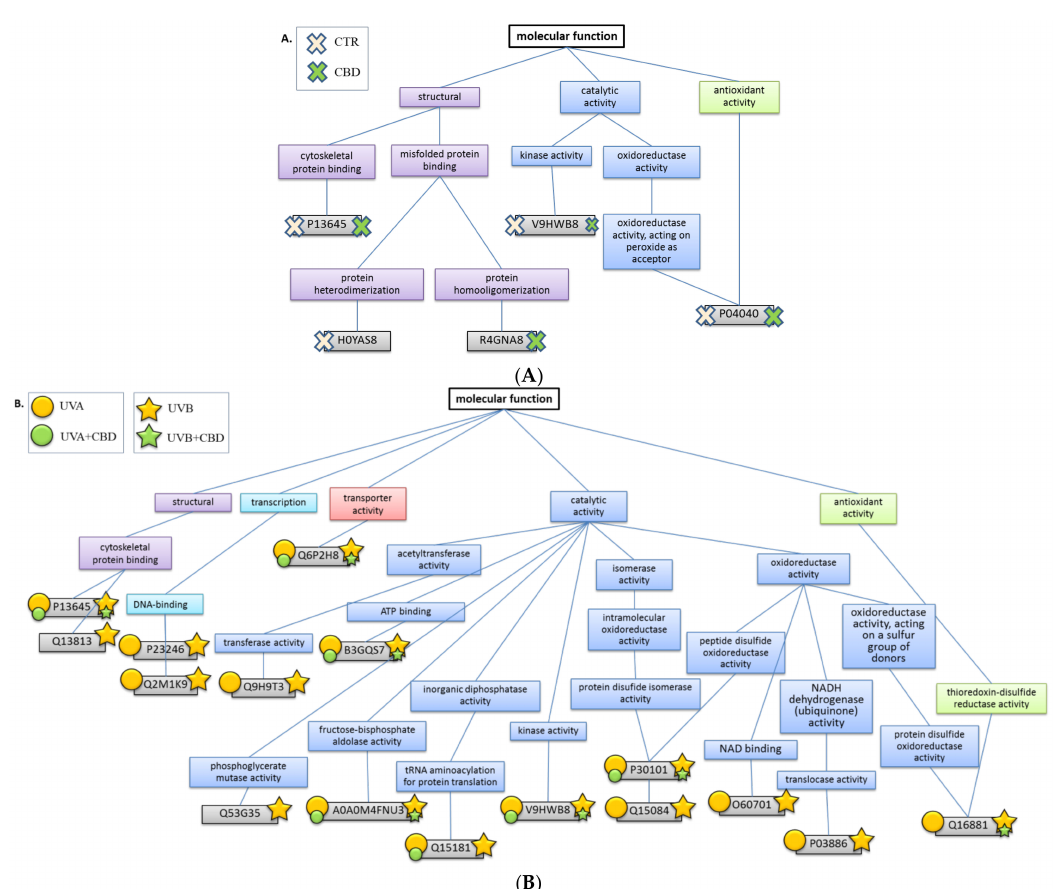
Figure 8. The biological function of proteins forming adducts with 4-hydroxynonenal (4-HNE) in keratinocytes treated in a three-dimensional culture model with cannabidiol (CBD, 4 µ M) ( A ) and following UVA (30 J/cm 2 ) or UVB (60 mJ/cm 2 ) ( B ) radiation. The size of the stamps indicates the statistically significant differences between the estimated amount of the 4-HNE-protein adducts in the samples non-treated or treated with